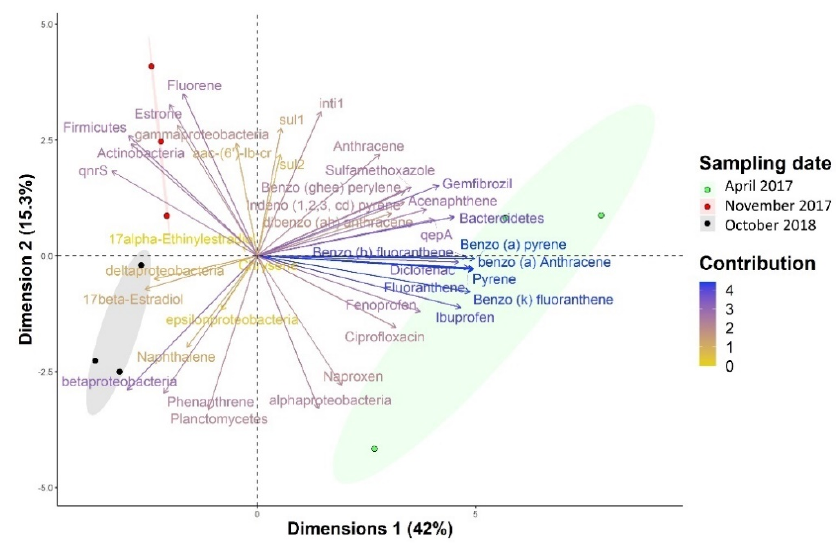
Figure 6. Principal component analysis (PCA) performed on overall data regarding pharmaceuticals, PAHs, ARGs and the main bacterioplankton groups obtained from the different sampling times and points. Green dots represent Point 1, Point 2 and Point 3 in the April 2017 sampling; red dots represent Point 1, Point 2 and Point 3 in the November 2017 sampling; and black dots represent Point 1, Point 2 and Point 3 in the October 2018 sampling. The gradient contribution represents the contribution of the variables to each dimension (from yellow: weak to blue: strong).